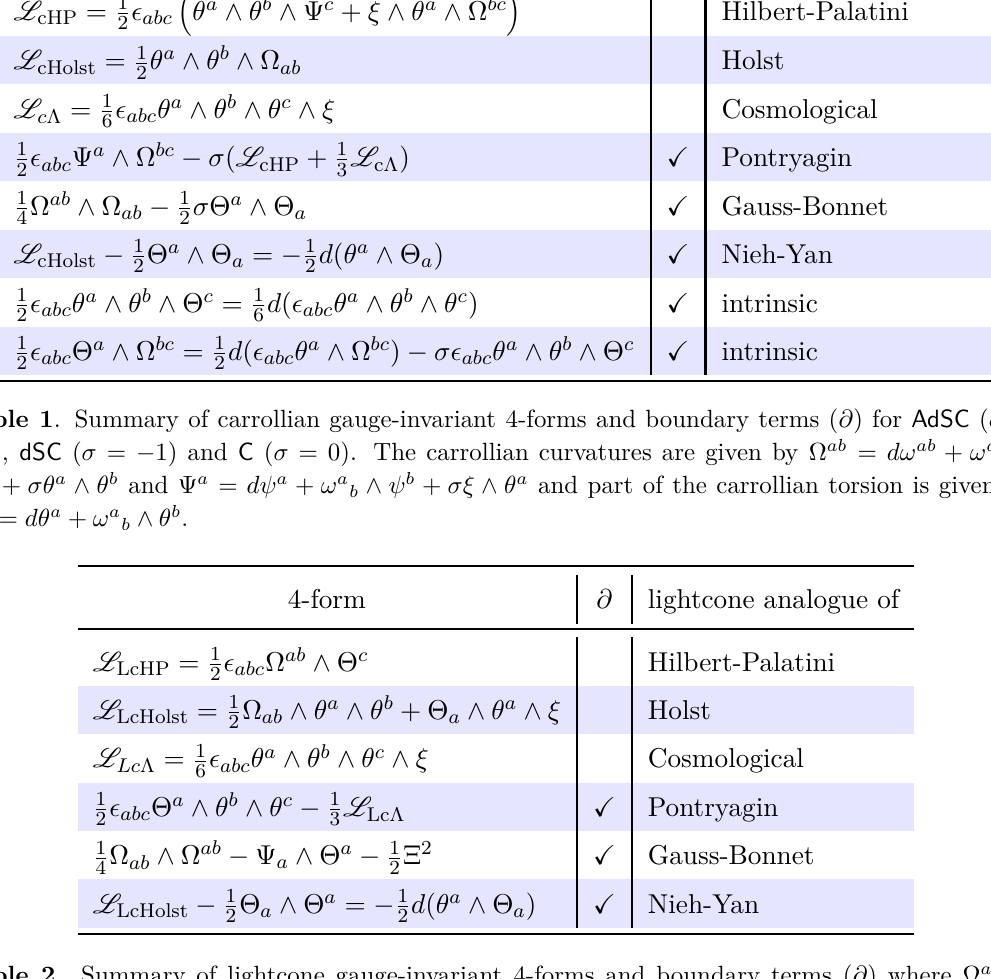
Table 2 . Summary of lightcone gauge-invariant 4 -forms and boundary terms ( ∂ ) where Ω ab = and Ξ = dξ + ψ a ∧ θ a